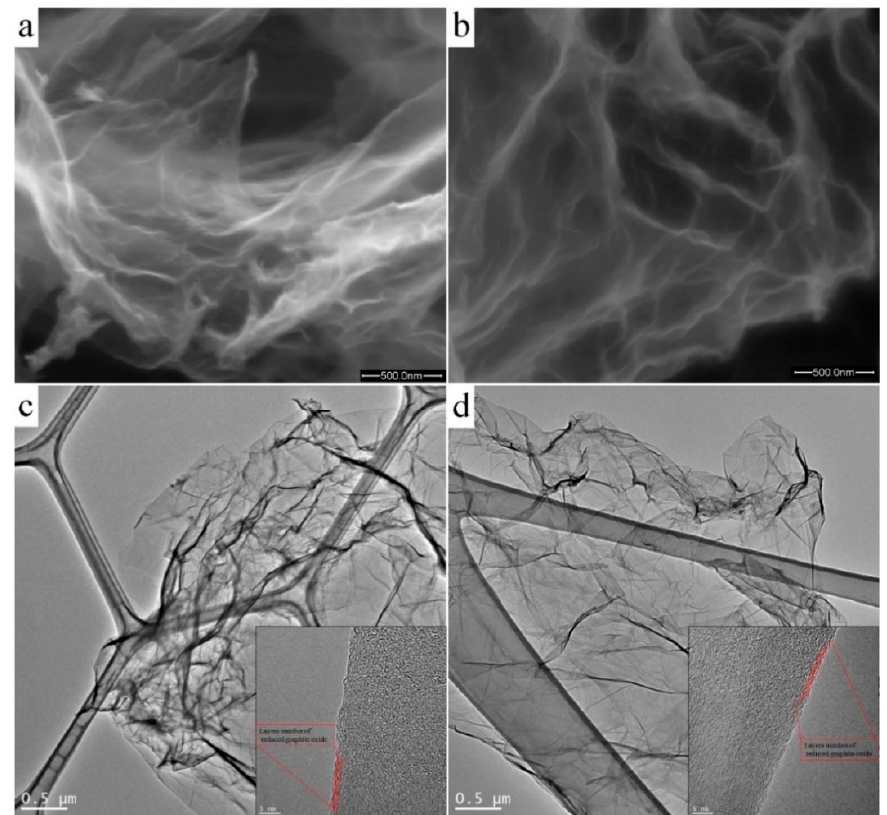
Figure 2. SEM and TEM images of the nitrogen-doped reduced graphite oxide (RGO) samples GO:N 2 H 4 –1:1 synthesized with a mass ratio of graphite oxide to hydrazine of 1:1 ( a and c , respectively), and GO:N 2 H 4 –1:4 synthesized with a mass ratio of graphite oxide to hydrazine of 1:4 ( b and d